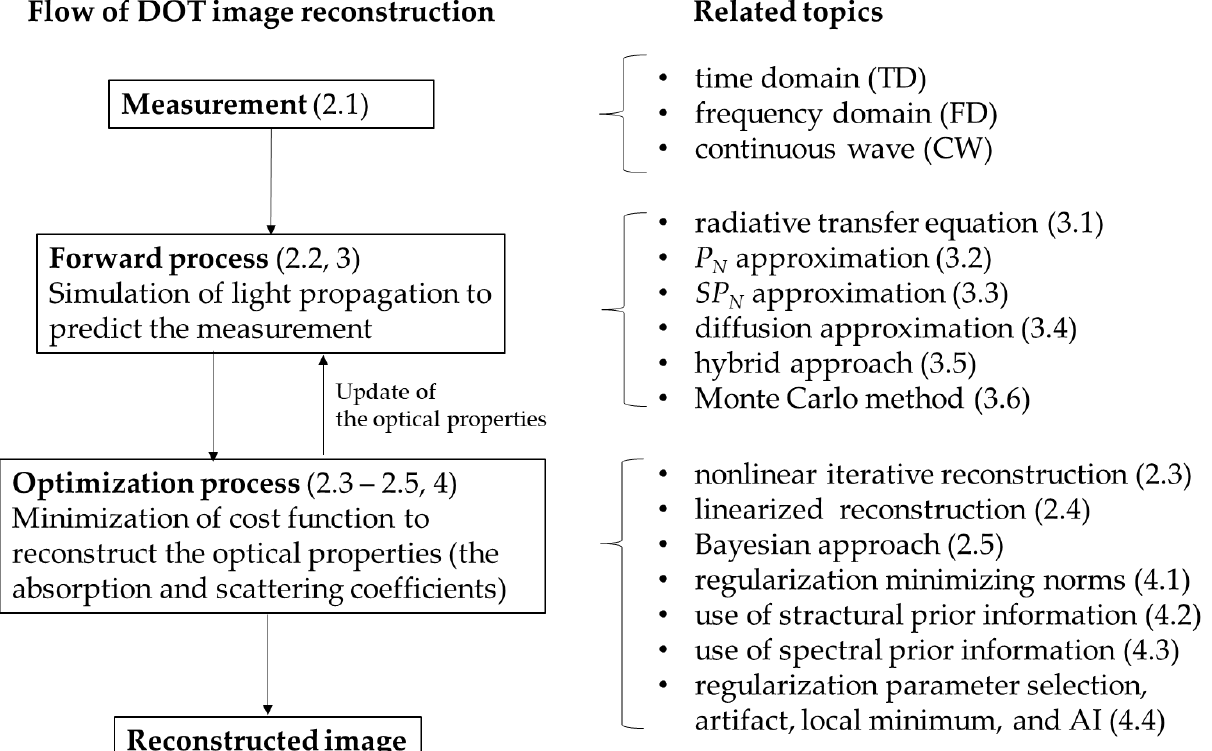
Figure 1. Flow of DOT image reconstruction and topics related to the processes in image reconstruction mentioned in this review together with corresponding section numbers.